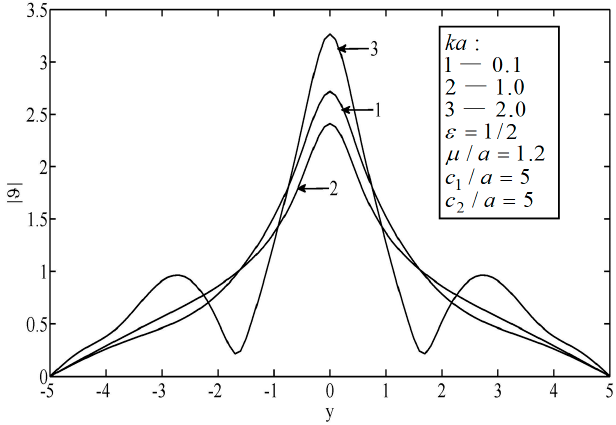
Figure 3. Temperature on the surfaces of the block.